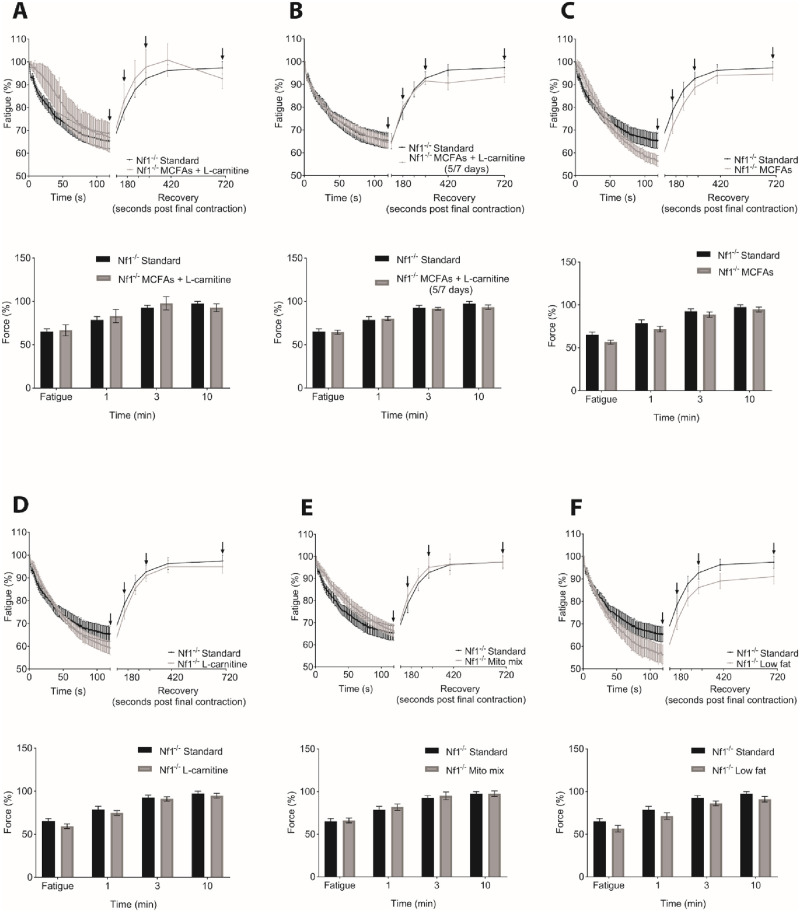
Dietary treatment effects on muscle fatigue and recovery in Nf1Prx1-/- TA muscles were unobservable.Fatigue and recovery response of (A) MCFA enriched diet supplemented with L-carnitine (B) MCFA enriched diet supplemented with L-carnitine treatment modelling cheat days (5/7 days) (C) MCFA enriched diet (D) L-carnitine supplementation alone (E) L carnitine in combination with riboflavin, CoQ10 and creatine, a common mitochondrial mix and (F) Low fat diet, at final fatigue measure (120th contraction), 1, 3 and 10 min recovery period (arrows) showed no difference. N = 10 in situ TA muscles per group. Data presented as group mean ± SEM. p-values were assessed by non-parametric ANOVA.